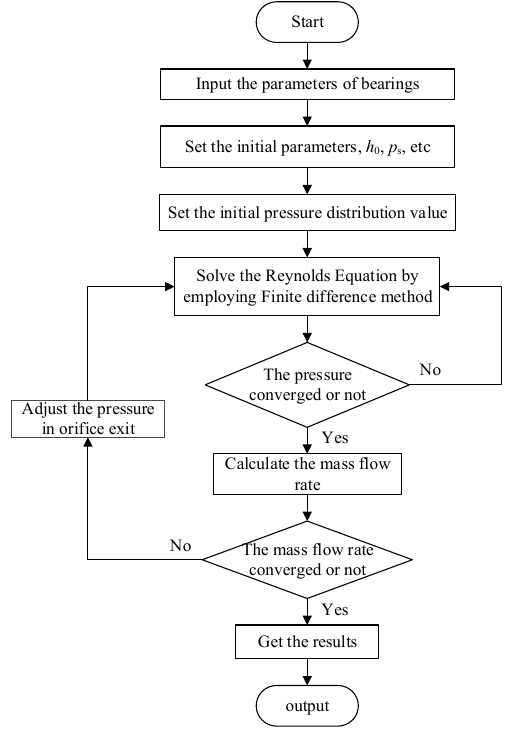
Figure 3. Calculation flow chart of gas journal bearing.